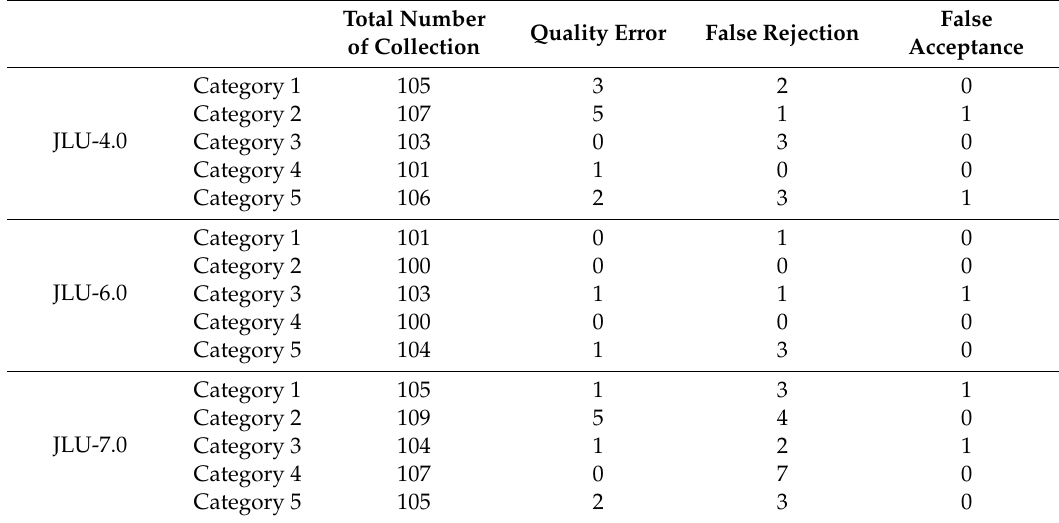
Table 16. The results of the heterogeneous universality experiment. Total Number Quality Error False Rejection of Collection